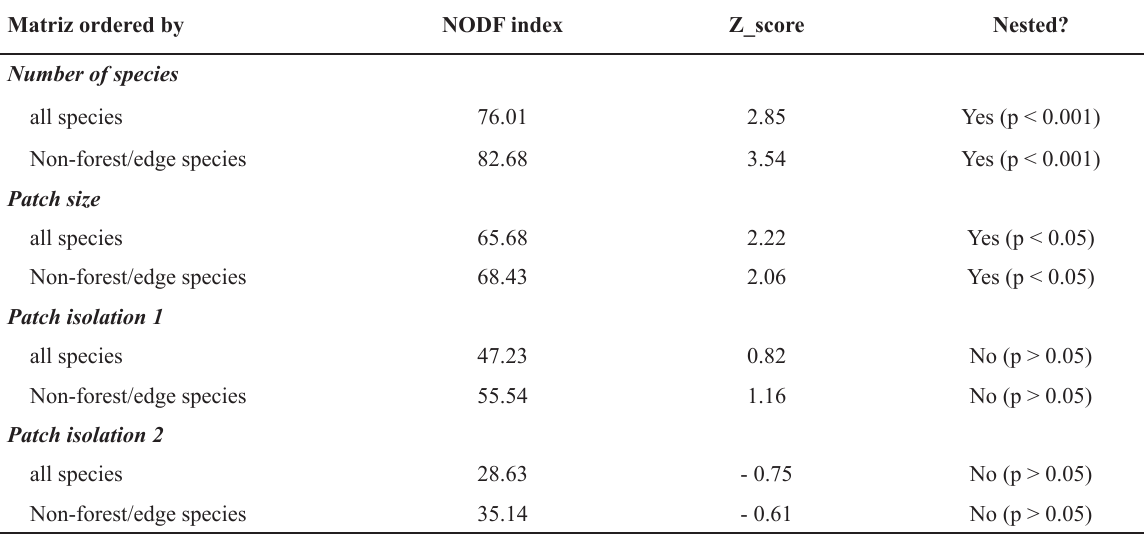
Results of nestedness analysis using nestedness metric based on overlap and decreasing fill (NODF) indices in matrices ordered by different criteria. The statistical significance of the NODF was accessed by 100 randomization of columns. Matriz ordered